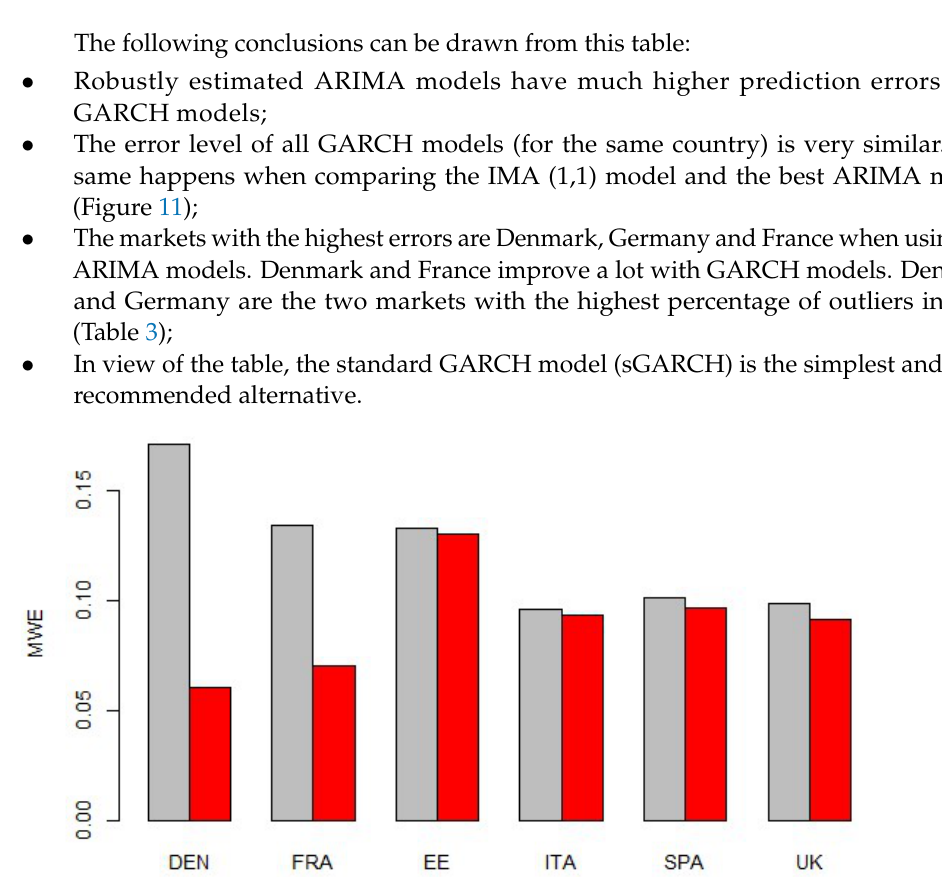
Figure 11. MWE of IMA (1,1) and sGARCH for each country (grey and red, respectively). Table 4 makes the same comparison if the models were to predict prices without anomalous data (a situation that is unrealistic but provides information on the sensitivity of the models). In this case the ARIMA and GARCH models provide very similar results. The simplest and most recommended model would be the IMA (1,1) model. Table 4. MWE for a situation that is unrealistic but provides information on the sensitivity of the models